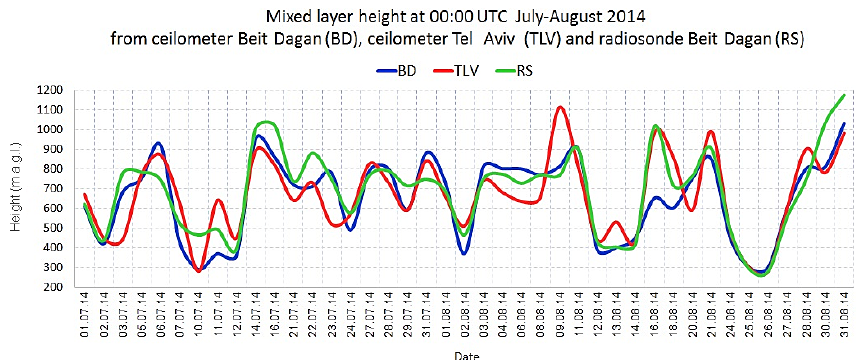
Figure 9. Same as Fig. 8 but for 00:00UTC based on 41 days between 1 July and 31 August 2014 with full data from the three